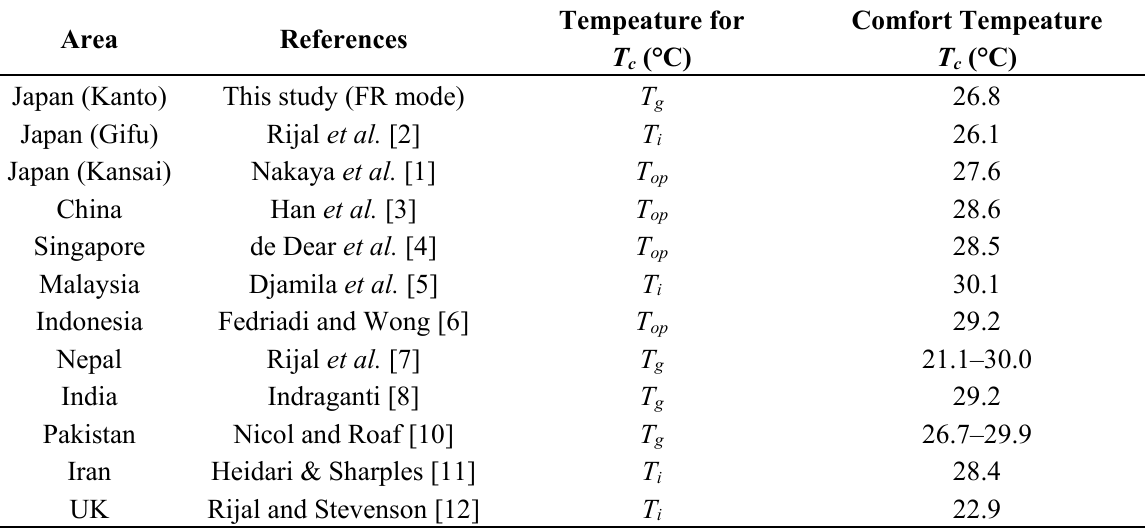
Figure 6. Comfort temperature predicted by Griffiths method: ( a ) Comfort indoor air temperature; ( b ) Comfort globe temperature. Table 9. Comparison of comfort temperature in summer with existing